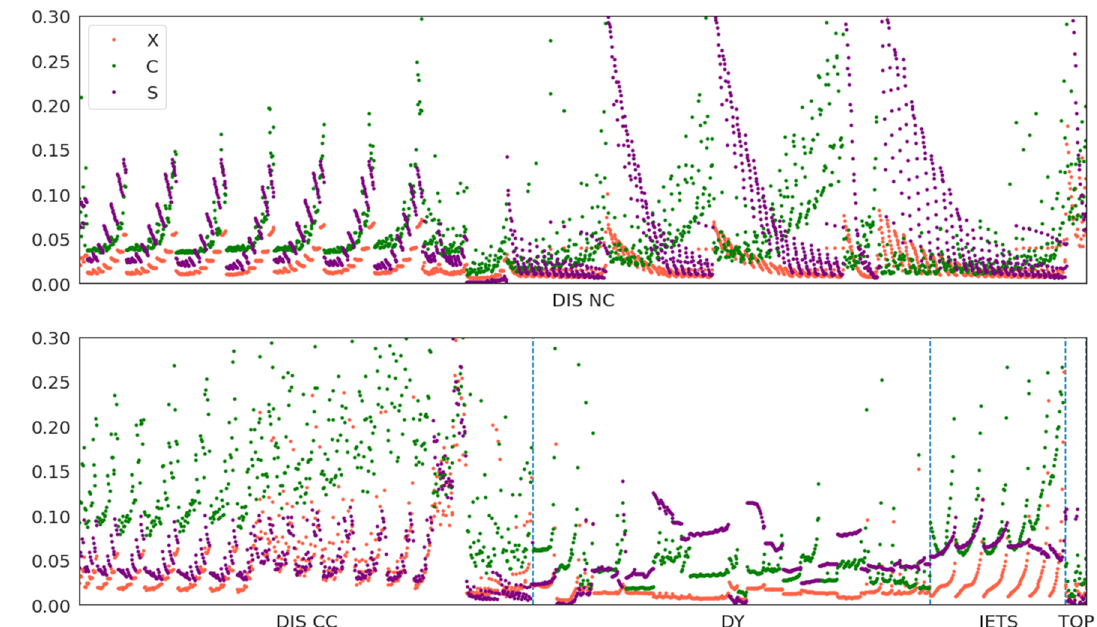
Fig. 3 The square root of the diagonal elements of the matrices X (in orange), C (in green) and S (in purple) normalized to the theoretical ( 0 ) , with those for C and S the same as in Ref. [9]. The datasets are arranged in the order given in Fig. 7 below predictions T i